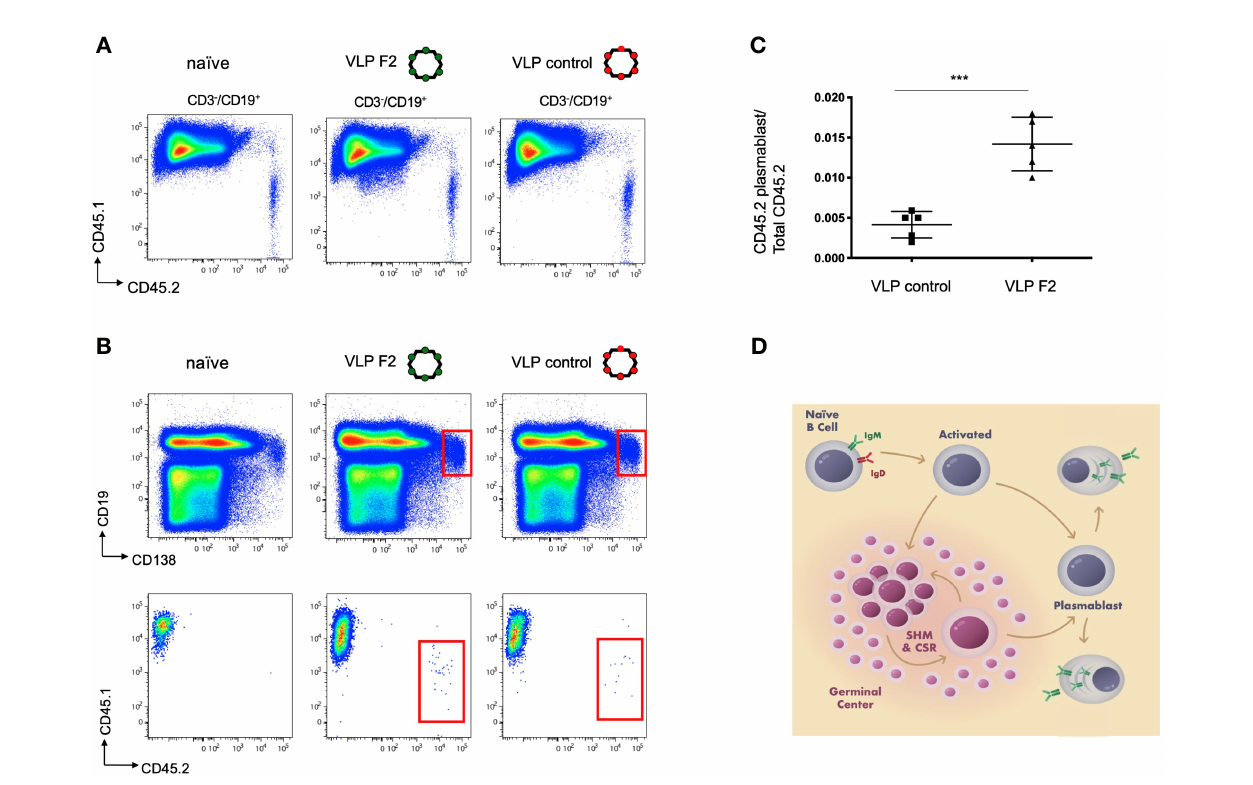
FIGURE 4 | Selective IGHV1-2*02 B cell lineage expansion using the engineered vaccine immunogen VLP F2. (A) CD45.1 +/+ mice received IGHV1-2*02 IgM B cells (1x10 6 B cells per recipient) and were then either unimmunized, immunized with control VLP or immunized with VLP F2. CD45.1 vs CD45.2 reactivity is shown for CD3 - /CD19 + B cells in each group. (B) CD45.1 vs CD45.2 reactivity was then evaluated within the plasmablast gate (CD19 int /CD138 + ). (C) IGHV1-2*02 B cells expanded to plasmablasts in animals immunized with control VLP or VLP F2 (mean ± SD, n = 5 per group, standardized as the proportion of the total IgM IGHV1- 2*02 B cells transferred to each recipient animal ***P < 0.001, Student ’ s T test). (D) Extrafollicular and follicular pathways for B cell activation and expansion following immunization, starting from the naïve IgM BCR stage through to differentiation to plasmablasts and plasma